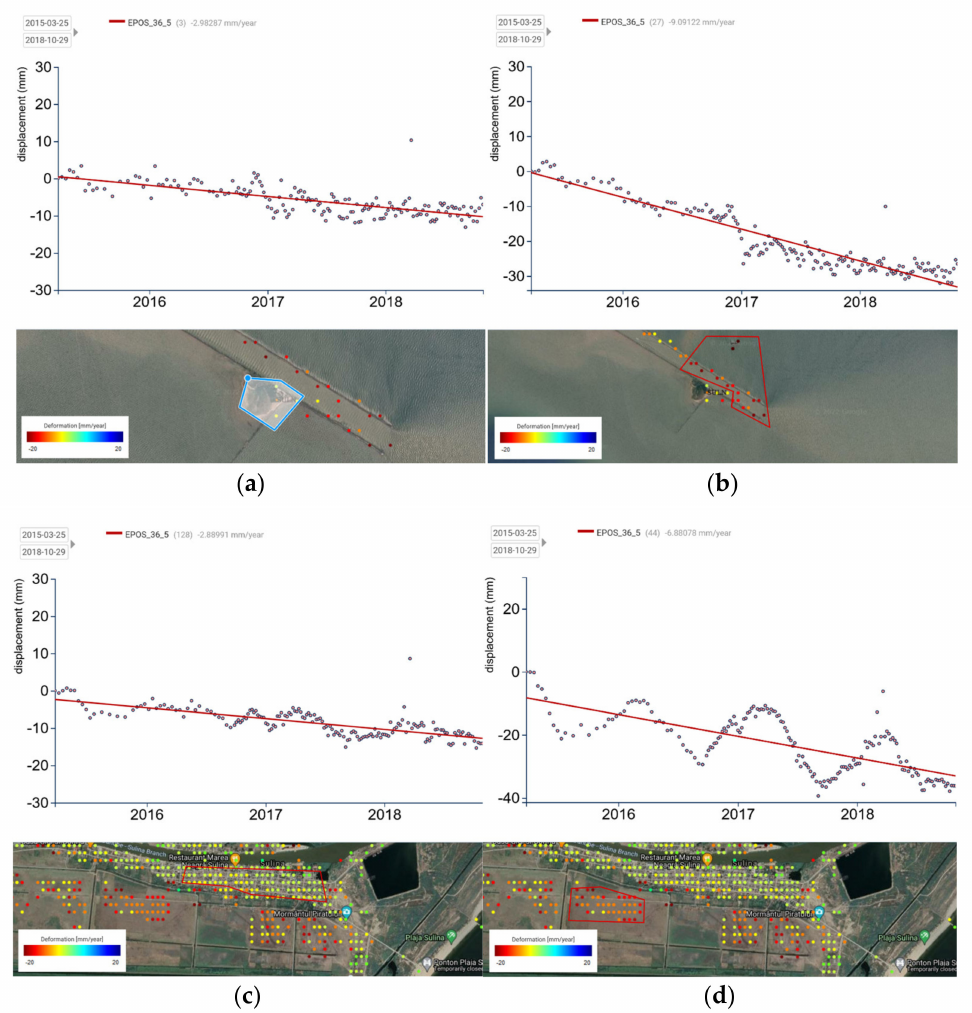
Figure 15. PSInSAR measurements in the SULN GNSS area. ( a ) SULN GNSS station area, − 3mm/year; ( b ) SULN GNSS station neighboring area, − 9.2 mm/year; ( c ) Sulina city, − 3 mm/year; ( d ) polder south of Sulina city, − 6